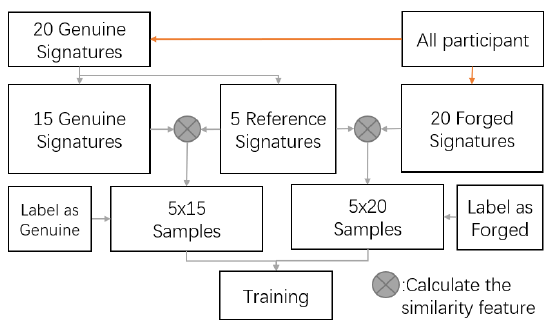
Figure 5. Model training design